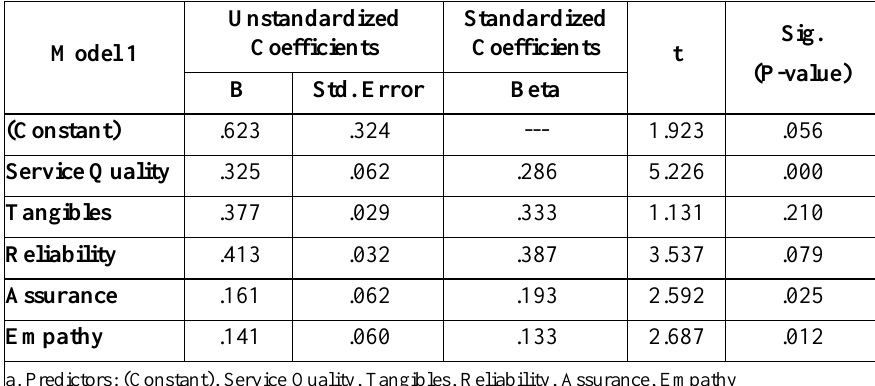
Table 7: Regression Coefficients